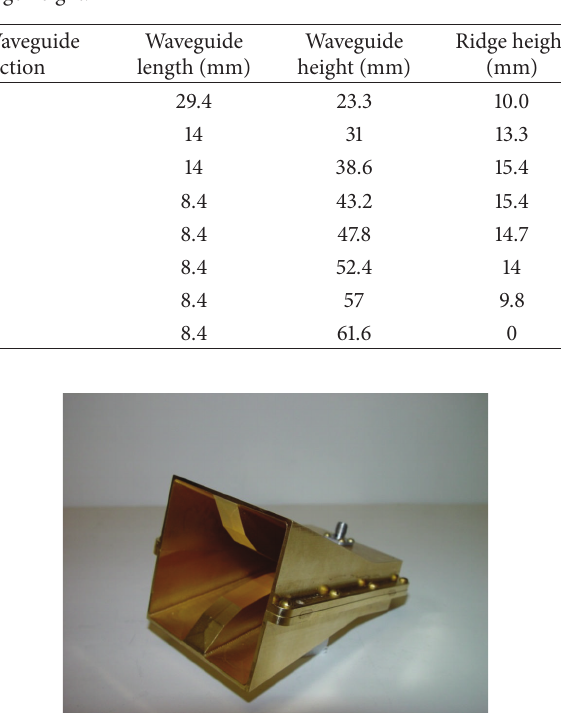
Figure 3: Fabricated double-ridged horn antenna